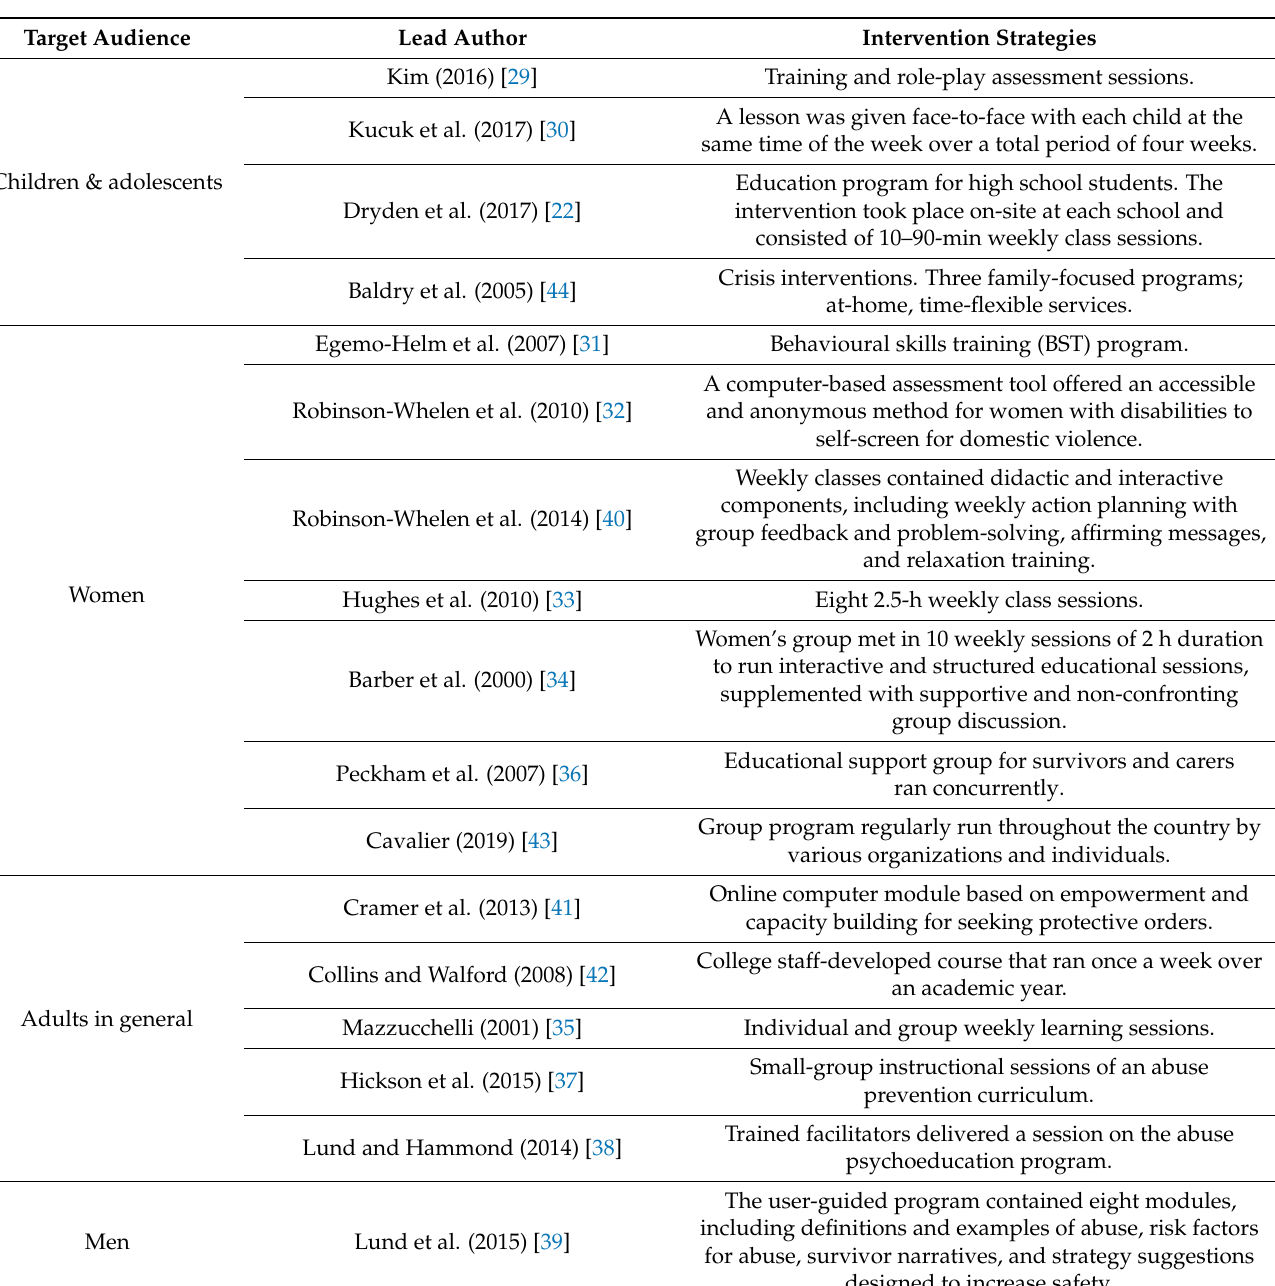
Table 3. Description of strategies per target